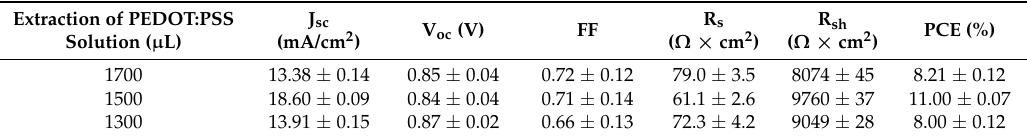
Table 1. The photovoltaic performance of the inverted PSCs 1 fabricated using three extractions of PEDOT:PSS solution of 1700, 1500, and 1300 µ L, and the 100 nm